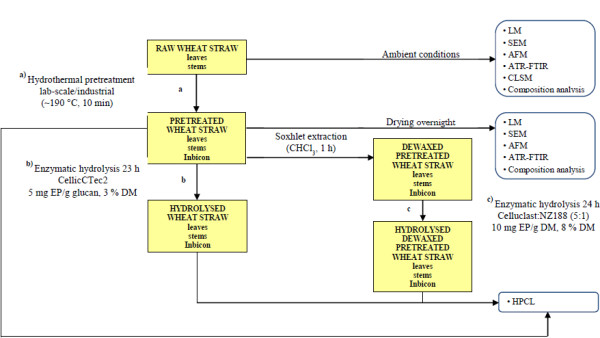
Experimental setup.